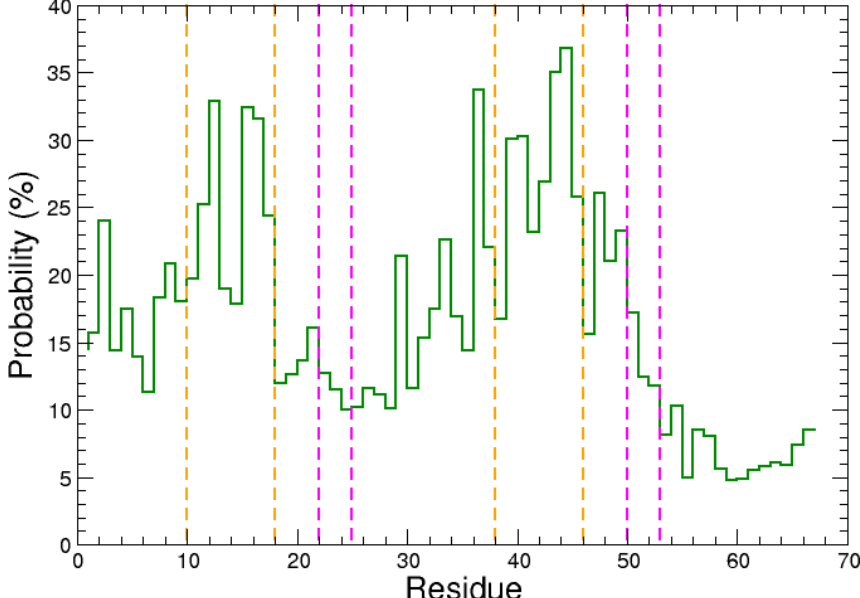
Figure 1. Probability of the N-WASP domain V residues to be distant by less than 4 Å from actin. Orange and magenta dashed lines indicate the protein regions in α -helix (as revealed by the X-ray structure 2VCP [27]) and the consensus sequences “LKKV” [14,31],